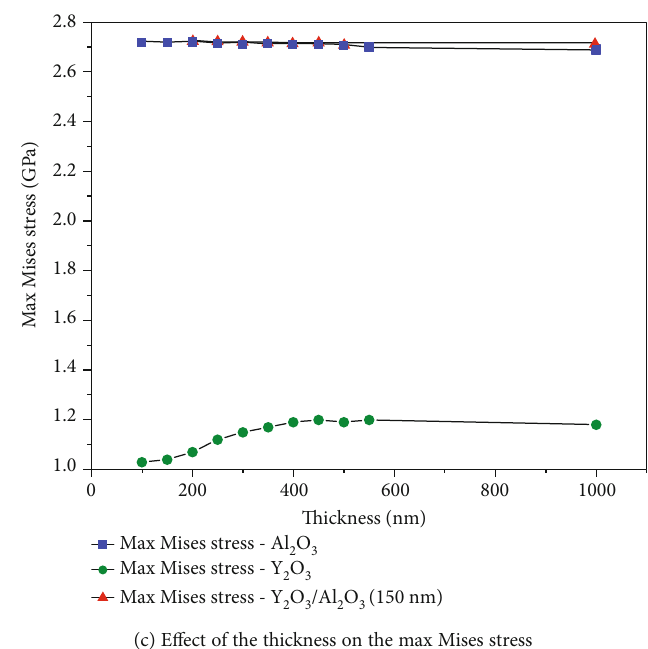
(c) E ff ect of the thickness on the max Mises stress Figure 4: E ff ect of thickness on di ff erent kinds of stress in the system: (a) e ff ect of the thickness on the max principal stress, (b) e ff ect of the thickness on the max shear stress, and (c) e ff ect of the thickness on the max Mises